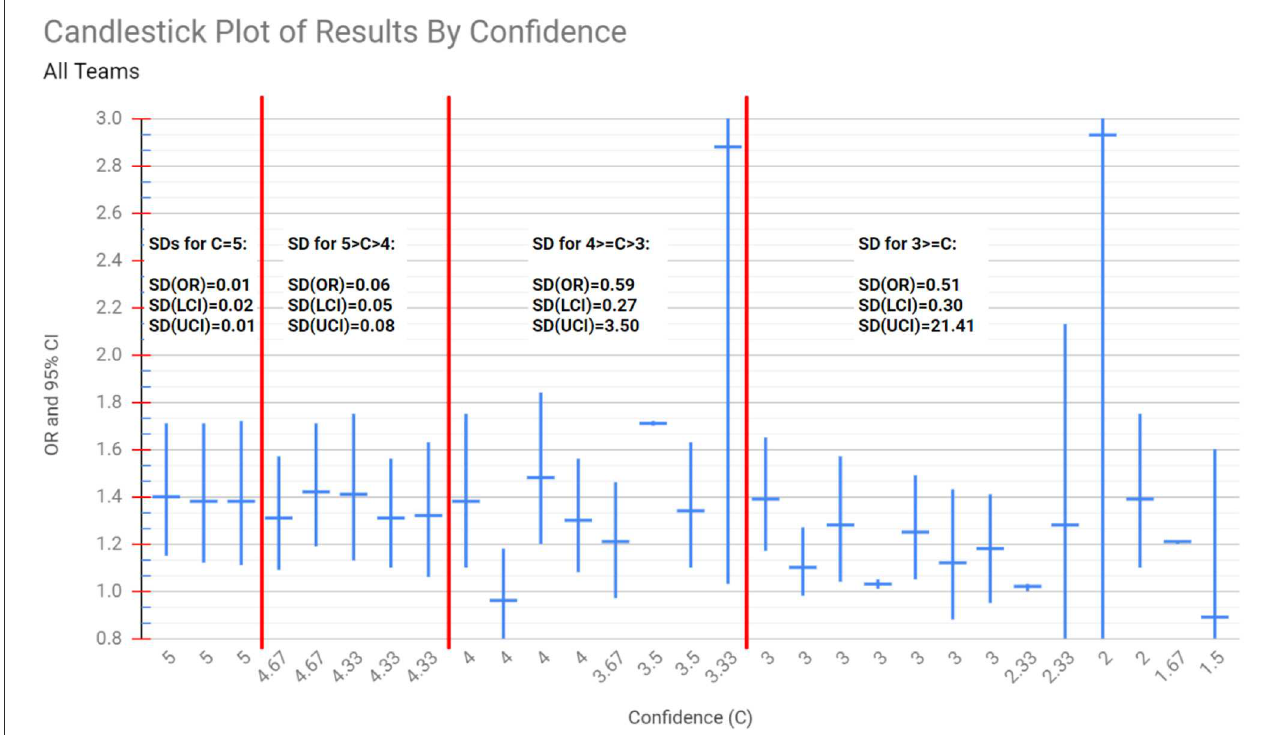
FIGURE2 The ORs and 95% CIs reported by the analysis teams in Silberzahn et al. (2018), sorted from left to right in decreasing order of Confidence (C), as rated by their peers (a proxy for peer estimated expertise). The vertical red lines separate groups of teams whose Confidence fell into specific categories: C = 5, 5 > C > 4, 4 > = C > 3, and C < = 3. The variance among the ORs and CIs of the teams that received high Confidence scores is low, but increases as C decreases. For example, across the teams with C = 5, the standard deviation (SD) of their Odds Ratio (OR), Lower Confidence Interval (LCI) and Upper Confidence Interval (UCI) are 0.01, 0.02, and 0.01 respectively, while for teams with C < = 3 the corresponding SDs are 0.51, 0.30, and 21.41. This inverse relationship between Confidence and the variance of results across teams was not identified explicitly by Silberzahn et al.